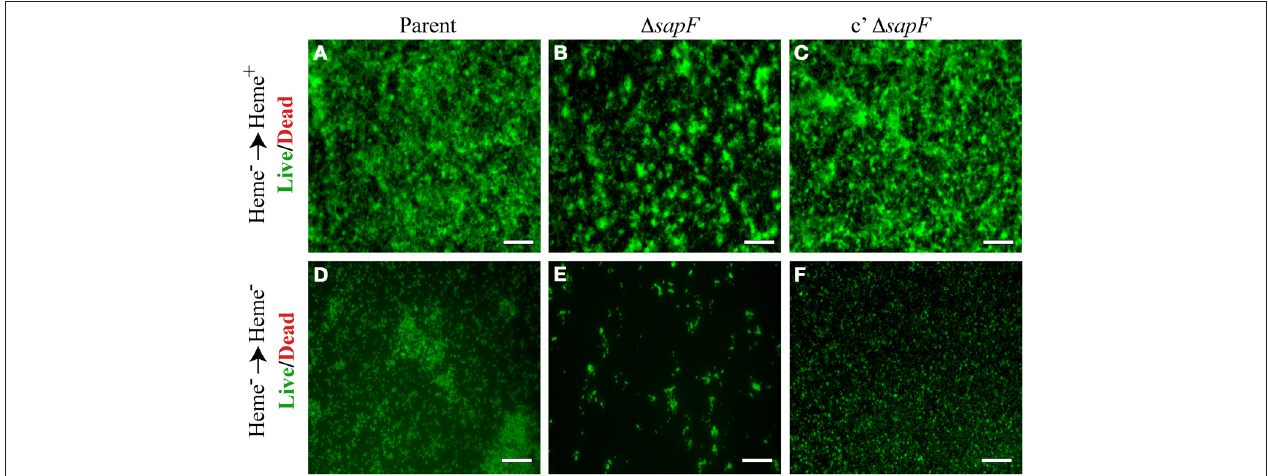
slides with DIS medium containing 0 or 2 μ g heme/mL for 24h. Biofilms were stained with the Live/Dead viability stain and the structure